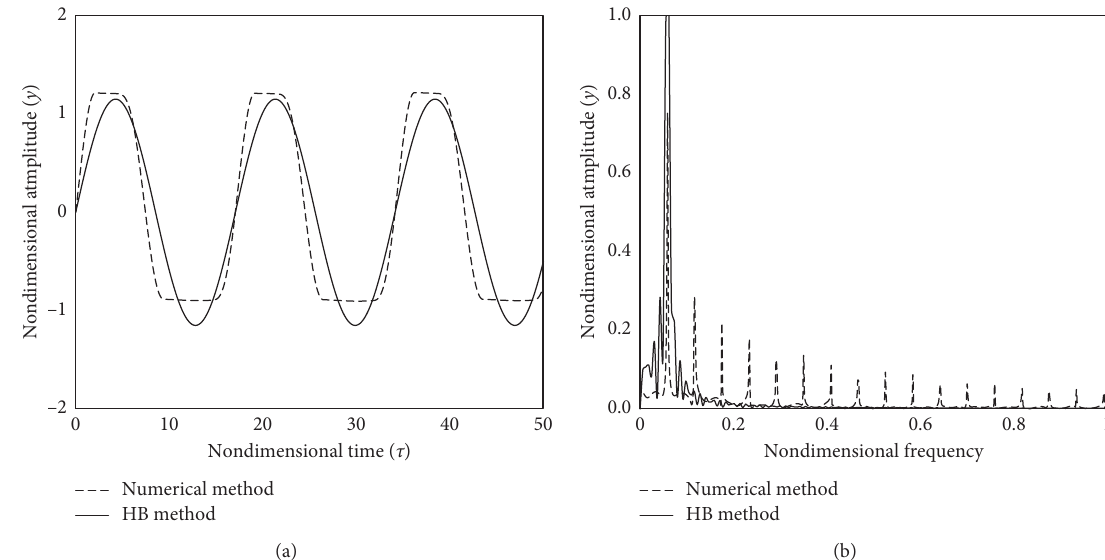
Figure 10: The results of HB and numerical method when a � 11 . 14, ψ � 0 . 368. (a) Time-domain curves. (b) Spectrum